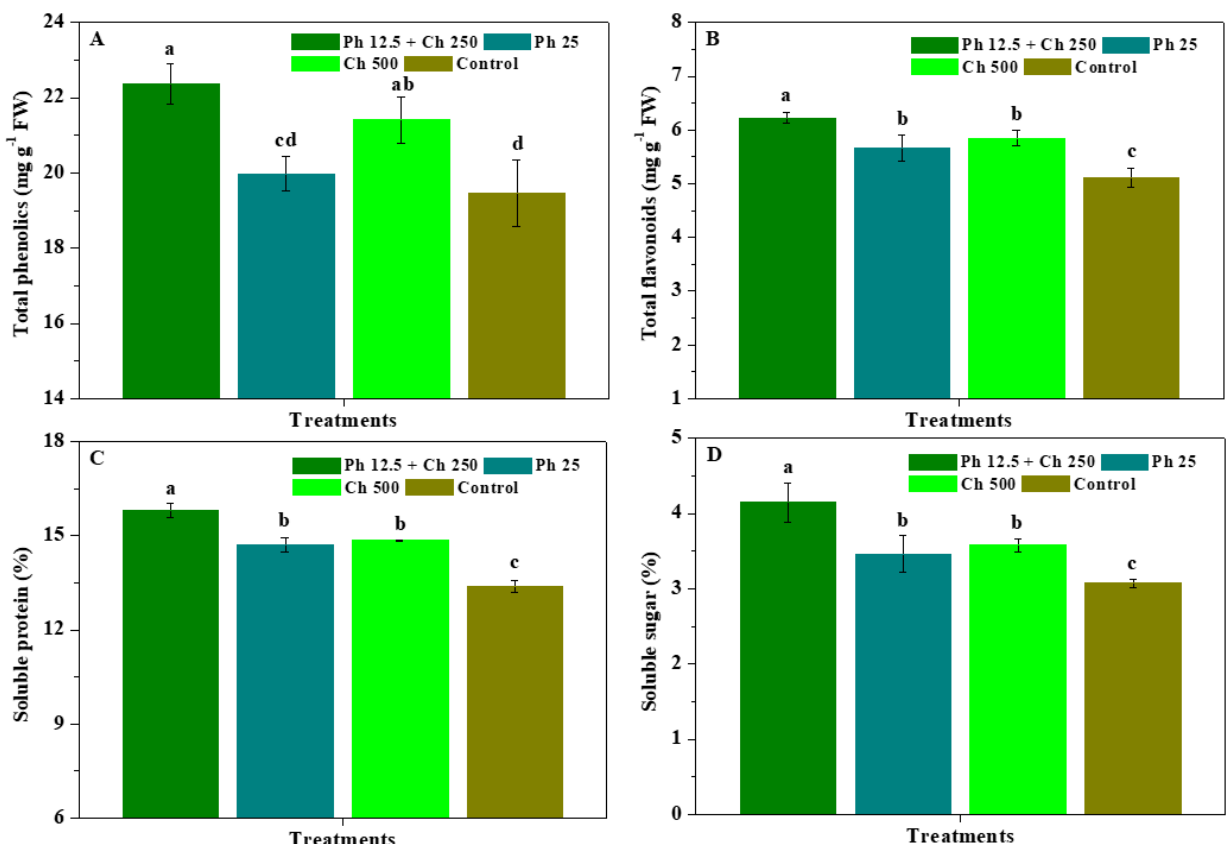
Figure 1. The impacts of physcion + chitosan, physcion, and chitosan on the phenolics ( A ), flavonoids ( B ), protein ( C ), and sugar ( D ) of leaves. The significant differences in the five treatments at 5% ( p < 0.05) level are stood by different letters. Error bar represents the SD of three duplicates.